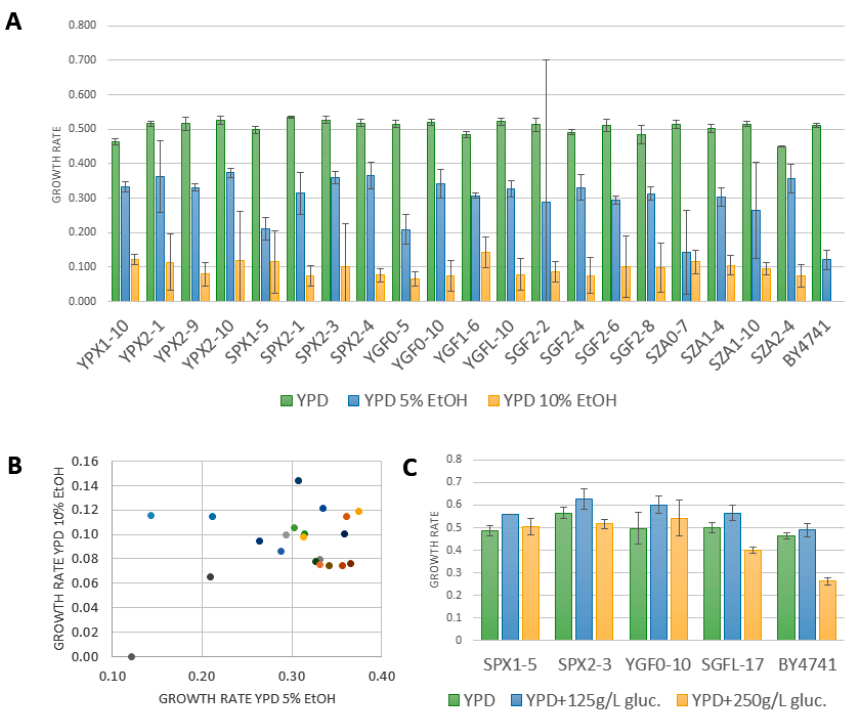
Figure 5. Phenotypic diversity of Aljarafe S. cerevisiae strains in growth tolerance to high ethanol and sugar concentrations. ( A ) Growth rate of the indicated strain at 0% ethanol (YPD), 5% ethanol (YPD 5% EtOH) and 10% ethanol(YPD 10% EtOH). ( B ) Relationship between growth rate at 5% versus 10% ethanol. Each dot represents these values for each strain. ( C ) Growth rate of the indicated strain at standard 20 gr/L glucose (YPD), 125 gr/L glucose (YPD + 125 g/Lgluc.) and 250 gr/L glucose (YPD 250 g/Lgluc.). Error bars are 95% confidence intervals.